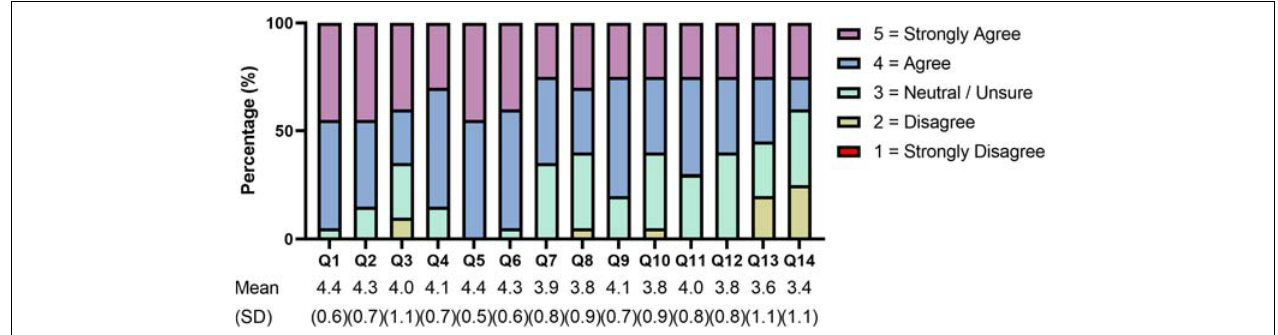
FIGURE 1 | COVID-19 Attitudes and Information. Items were rated using a 5-point Likert scale ranging from 1 (strongly disagree) to 5 (strongly agree). The items are listed below. Q1: I am well prepared for COVID-19. Q2: The local government is well prepared for COVID-19. Q3: The international community is